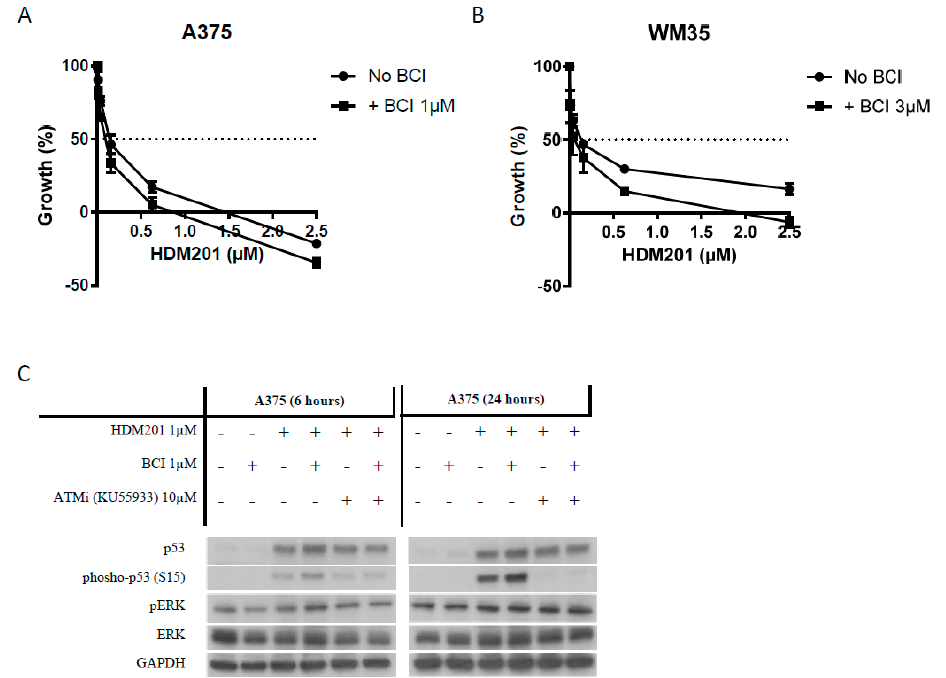
Figure 6. DUSP6 suppression by inhibitor (BCI) promotes the anticancer effect of MDM2 inhibitors through p53 phosphorylation. ( A , B ) Dose-dependent growth inhibition of A375 and WM35 treated with HDM201 ± BCI for 72 h. ( C ) Immunoblotting of A375 treated with HDM201 ± BCI ± KU55933 for 6 and 24 hours.